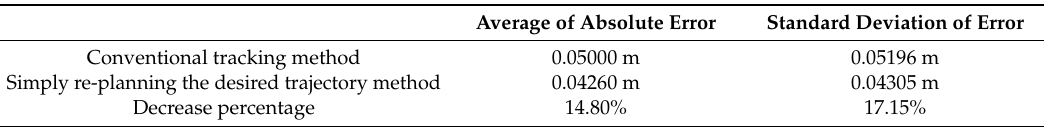
Figure 10. Comparative experiment results for simply re-planning the desired trajectory method and conventional tracking method with MPC tracking sinusoidal trajectory. ( a ) Depth data; ( b ) error data; and, ( c ) input u. Table 3. Statistical Result of Figure 10.